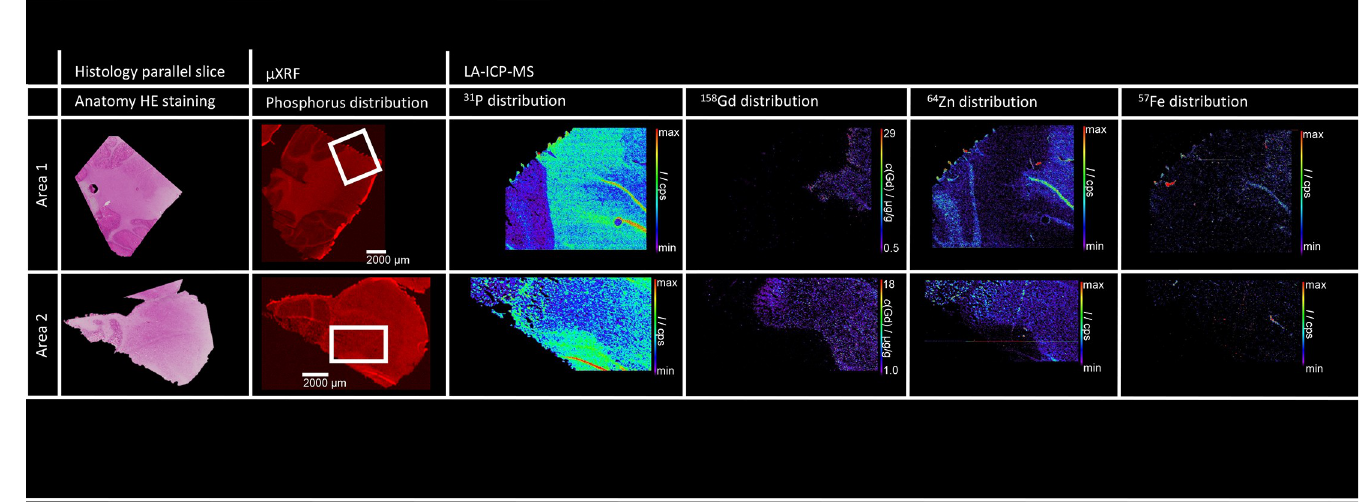
Fig 2. Representative results for the LA-ICP-MS analyses of two cryo cerebellum samples of one dog treated with gadodiamide 35 months before euthanasia. Anatomy is shown on histological and μ XRF images. LA-ICP-MS results are displayed as quantitative distribution map of gadolinium ( 158 Gd) and as qualitative distribution maps of phosphorus ( 31 P), iron ( 57 Fe) and zinc ( 66 Zn). LA-ICP-MS analyses were performed with a laser spot size of 10 μ m and a limit of detection at 67 ng/ g (LOD). A clear colocalization of gadolinium and zinc displays in both samples.